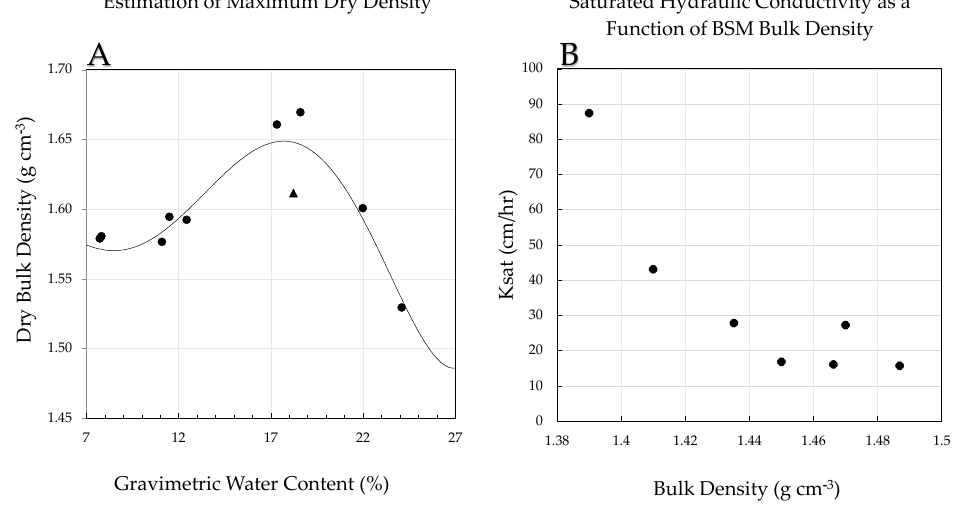
Figure 2. Bench-scale range finding experiments to determine the target bulk density for the field mesocosms. ( A ) Plot of bulk density as a function of water content. The triangular datum is a suspected outlier due to separation of the sand and compost while filling test apparatus. ( B ) Plot of saturated hydraulic conductivity as a function of soil bulk